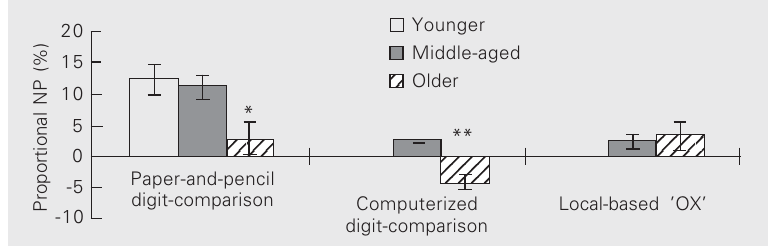
Figure 3. Proportional negative priming (NP) scores for each task in Experiment 3. Data are reported as the mean ± SEM. NP did not differ across younger and middle-aged participants in the paper-and-pencil digit-comparison task, F(1, 21) = 0.03, P = 0.956. The group of older participants showed reduced NP for digit-comparison tasks but preserved local-based NP relative to the NP scores derived from the performance of middle-aged participants; MANOVA (2 age x 3 task), Rao R (3, 12) = 16.02, P < 0.0002. Based on Tukey’s HSD *(P < 0.05) and **(P <